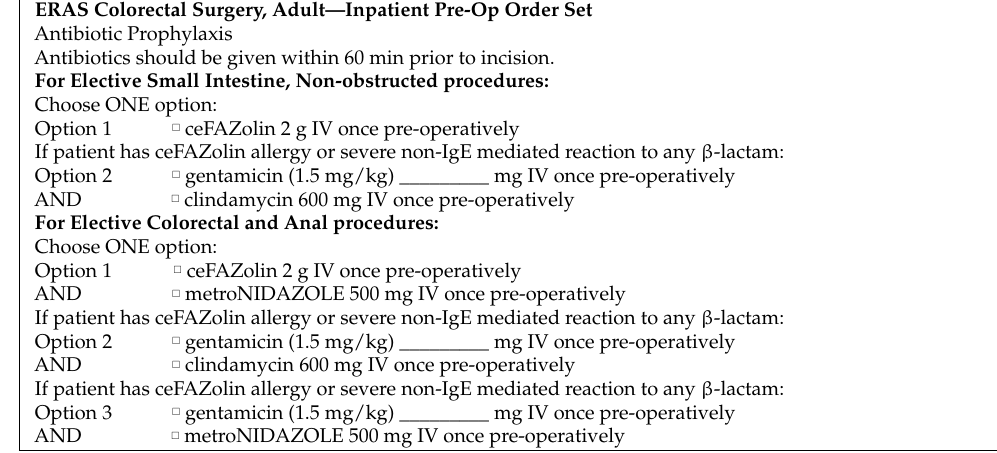
Table 2. Preoperative Antibiotic SSI Prophylaxis Order Set for ERAS ® Elective Small Bowel and Colorectal Procedures. (Note: “look-alike, sound-alike” medication names with TALLMAN letters to reduce medication error [14]).